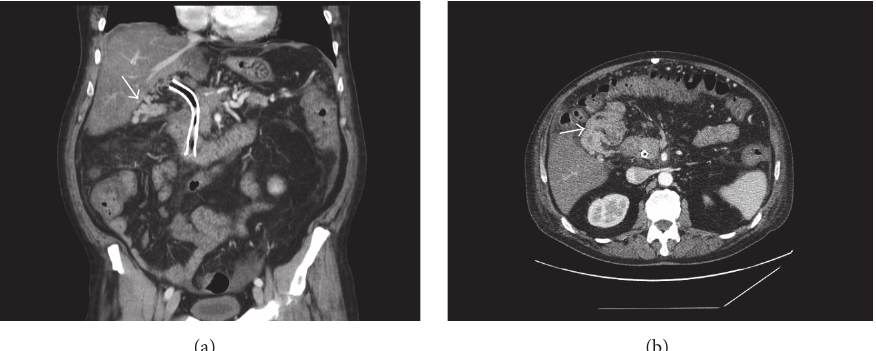
Figure 2: Abdominal contrast-enhanced CT. (a) Oblique plane, showing gallbladder varices, and (b) axial plane, showing gallbladder varices and cholecystoenteric